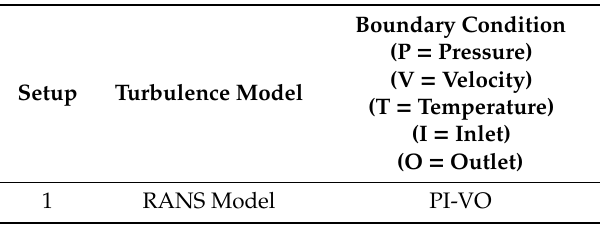
Setup Turbulence